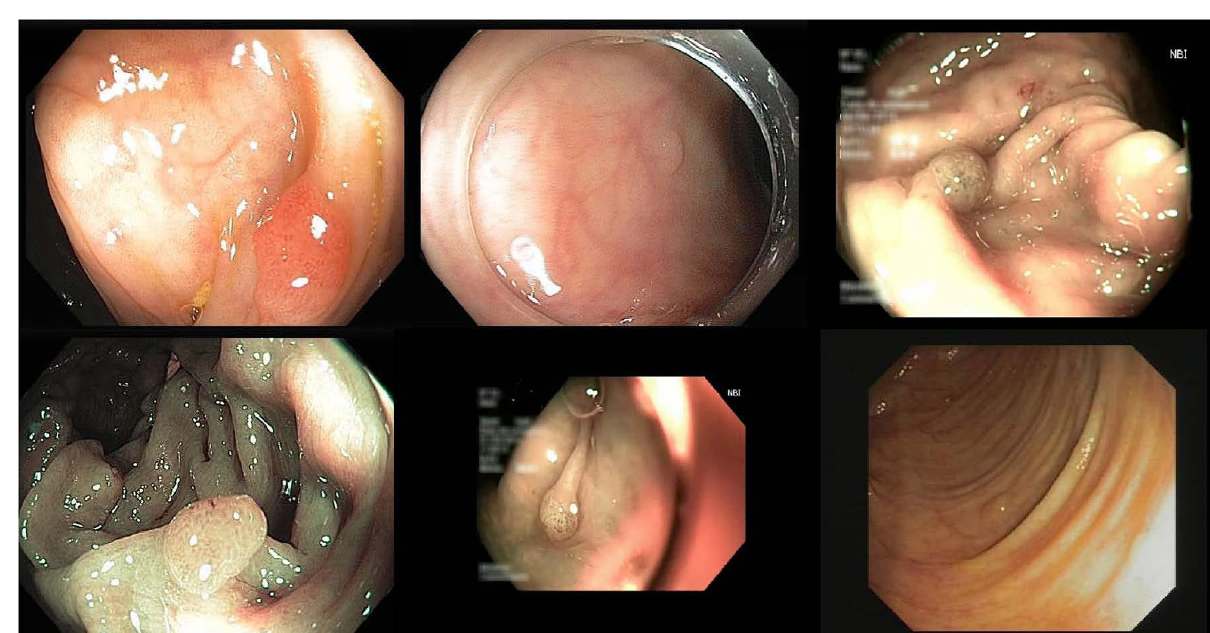
Fig 8. Six sample frames from the generated dataset.